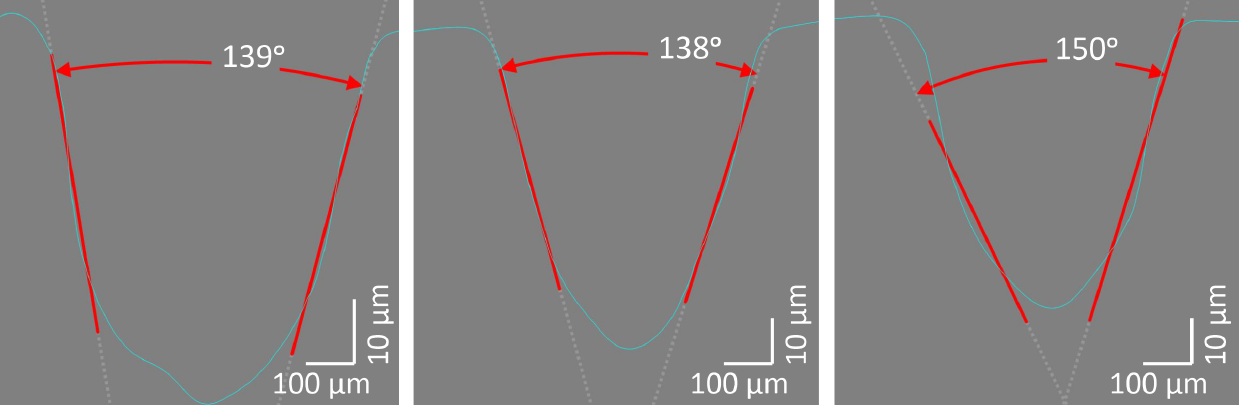
Figure 11. Effect of scan speed: F = 127 mm, P = 60 W; ( left ): S = 20 mm/s; ( center ): S = 300 mm/s; ( right ): S = 600 mm/s.